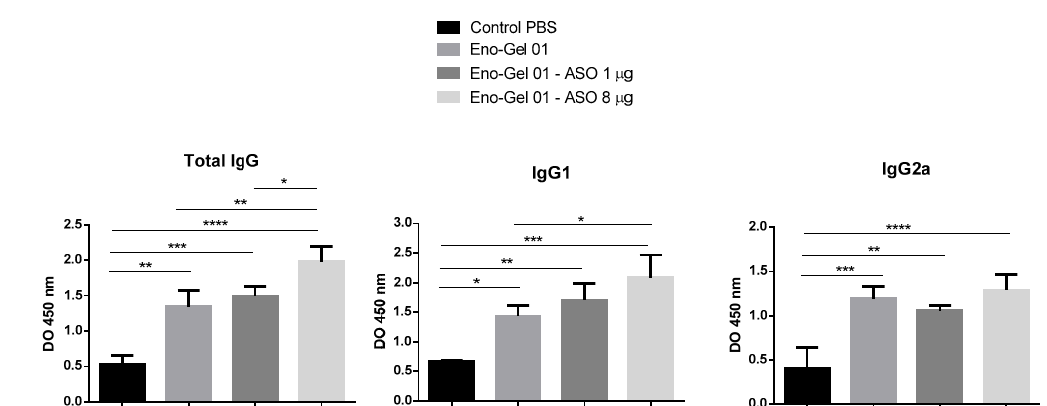
Figure 5. Specific antienolase antibodies. Mice (C57BL/6) were immunized on days 0 and 14. Specific antibodies to S. schenckii enolase in serum were evaluated on day 21 by means of ELISA. A one-way analysis of variance (ANOVA) with Tukey’s post hoc test was used. The confidence interval was established at 95% for all tests. The level of significance and p -values are shown as * ( p < 0.05); ** ( p < 0.01); *** ( p < 0.001); **** ( p < 0.0001).